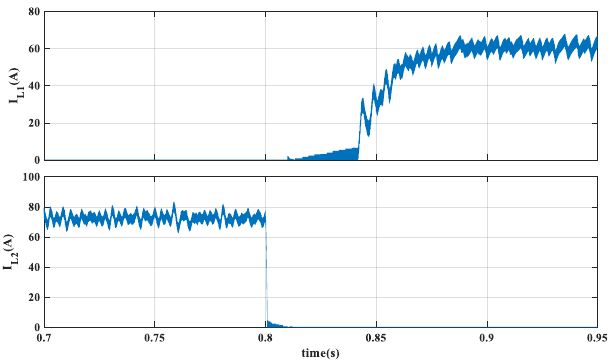
Figure 6. Inductor currents and 𝑆 3 − 𝑆 4 switching conditions during power a flow direction change.